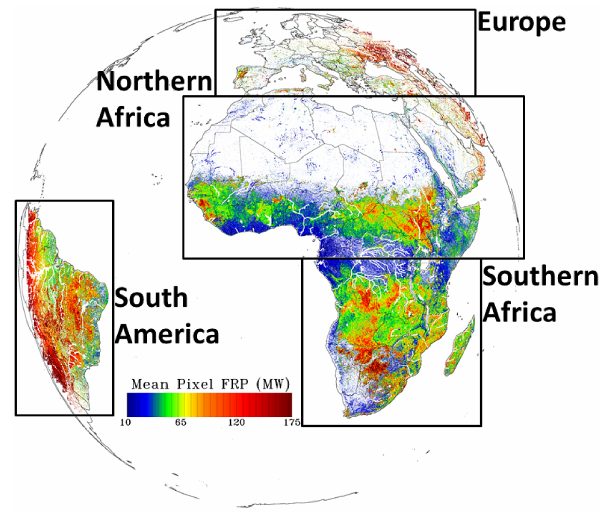
Figure 1. SEVIRI’s imaging disk showing the mean per-pixel FRP (MW) seen in each SEVIRI pixel, calculated using all FRP-PIXEL products available between 2008 and 2013. Also indicated are the four geographic regions that LSA-SAF SEVIRI products are subset